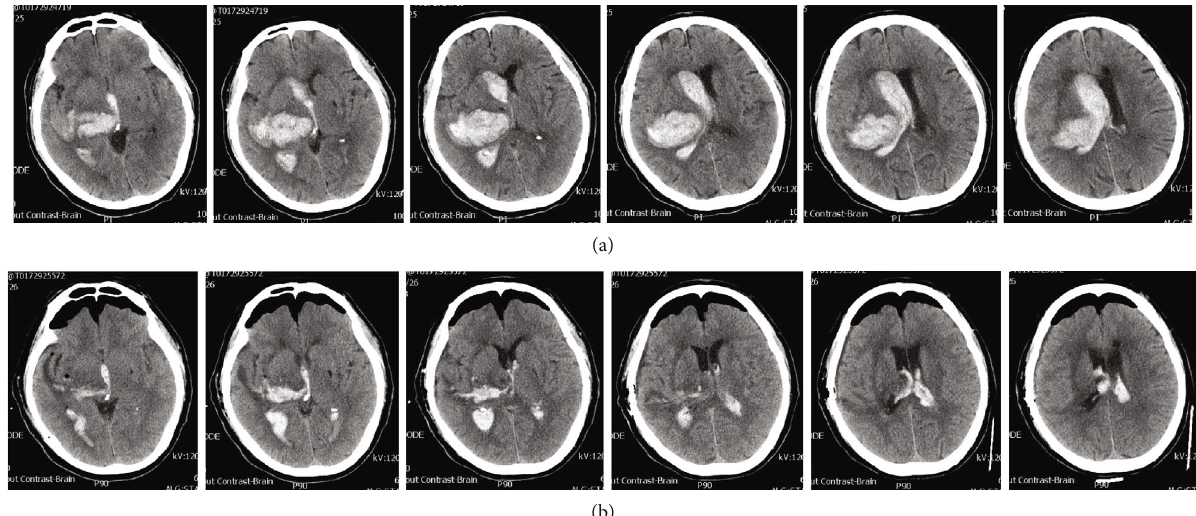
Figure 4: Axial CT scans. (a) Preoperative thalamic hematoma which ruptured into the ventricle. (b) Postoperative residual thalamic hematoma and intraventricular